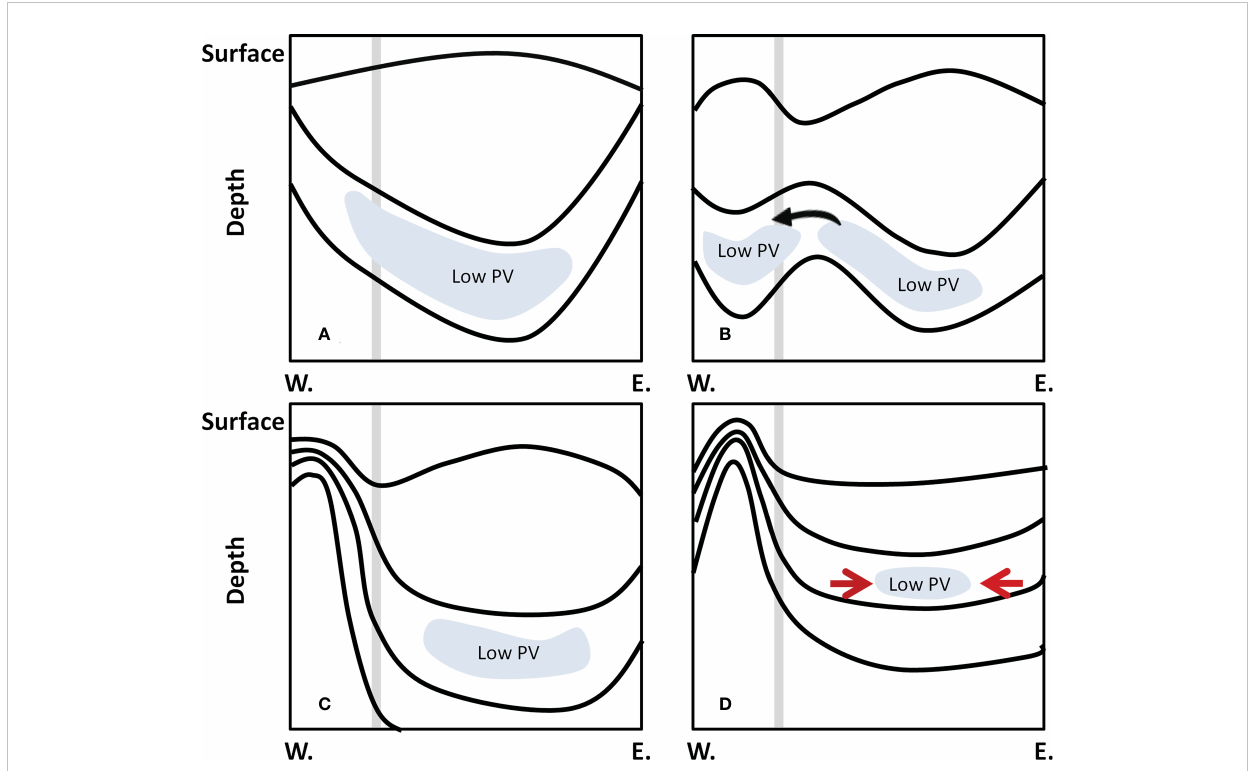
FIGURE 15 Schematics illustrating the mechanism by which a low PV signal (blue areas) can (cannot) be transported to the east of the Luzon Strait: a low PV signal reaches the Luzon Strait when the strati fi cation is (A) weak and (C) strong on the west side; the low PV signal (B) becomes isolated from and (D) weakens on the east side. The thick gray line represents the position of 122° E . The black lines illustrate the distribution features when the low PV signal can (cannot) be transported to the west of the Luzon Strait. The red arrows in the opposite direction in Figure 15D indicate low PV signal weakening. The crooked black arrow indicates the process of a low PV signal isolated from the AE east of the Luzon Strait. The isopycnals above and below the low PV water are the 1025 : 0kg · m − 3 and 1025 : 5kg · m − 3 isopycnals,